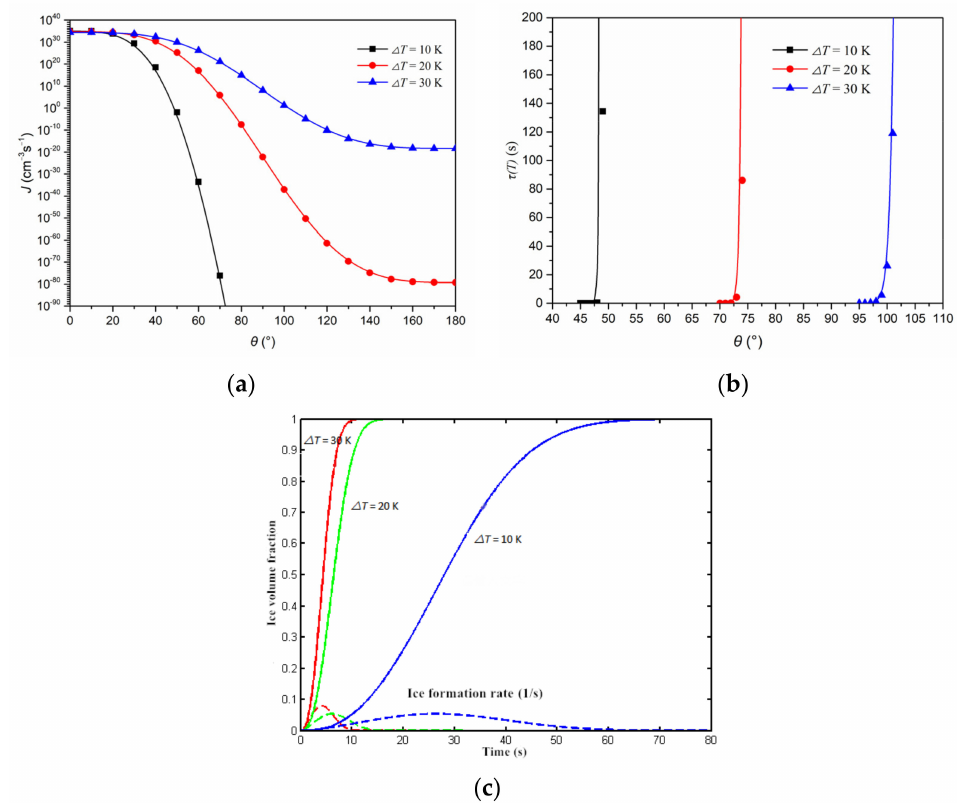
Figure 1. Ice crystallization characteristics in the MEA. ( a ) Crystal nucleus rate vs. contact angle. ( b ) Induction time vs. contact angle. ( c ) Ice volume fraction and ice formation rate vs. time, θ = 60 ◦ . The solid and dashed lines represent ice volume fraction and ice formation rate at different supercooling degree,